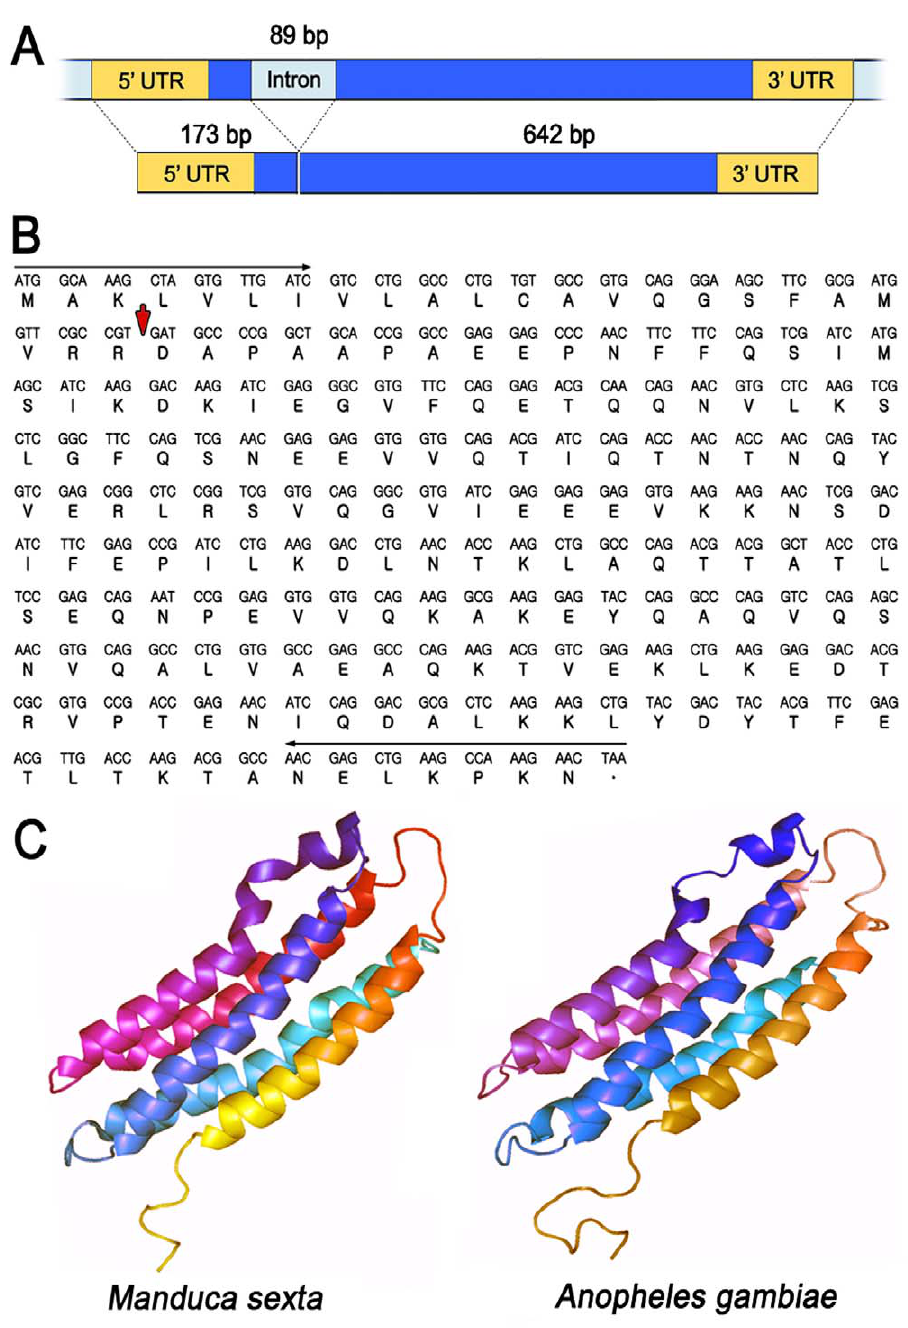
Figure 1. Genomic organization, cDNA and deduced amino acid sequence, and predicted tertiary structure of AgApoLp-III. (A) genomic organization, mRNA splicing and (B) cDNA sequence and deduced amino acid sequence of AgApoLp-III. (C) Tertiary structure of Manduca sexta and predicted structure of Anopheles gambiae ApoLp-IIIs.